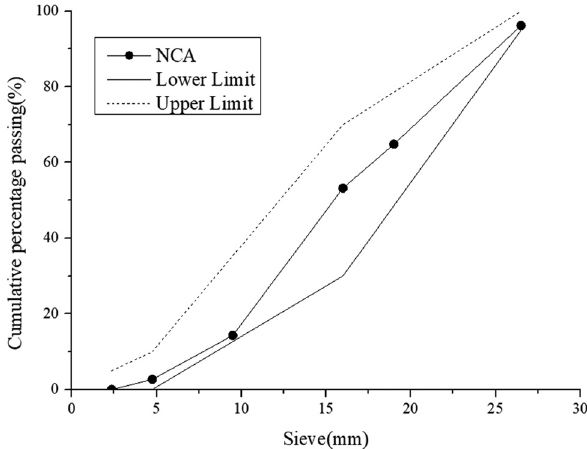
Figure 1: Sieving result of